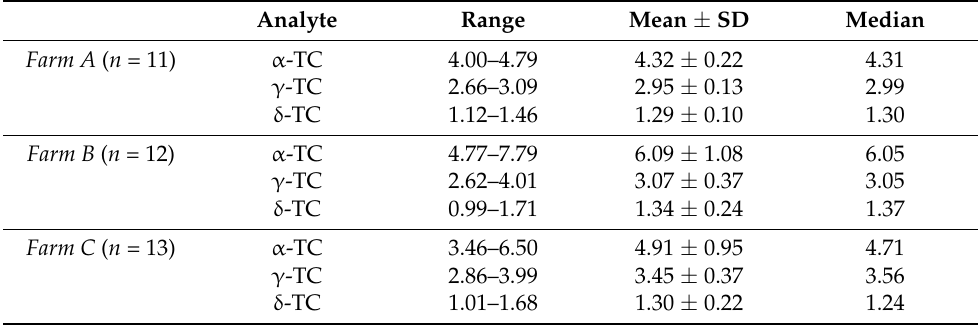
Table 3. Content (mg L − 1 ) of tocopherols in milk samples from Modicana cattle